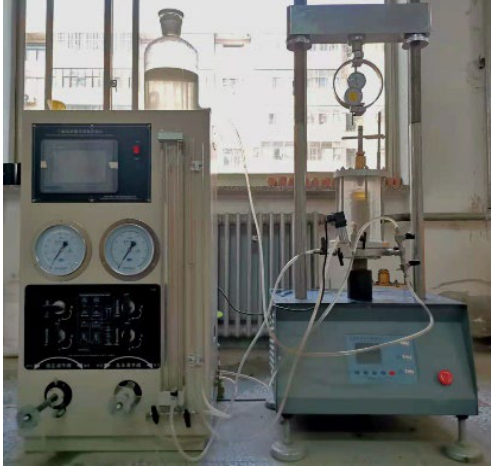
Figure 3. Strain-controlled triaxial apparatus.